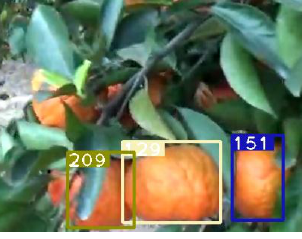
Figure 17. The majority of uncounted oranges are heavily obscured behind other oranges and leaves, the YOLO pretrained weights don’t fully accommodate brightness and occlusion challenges.